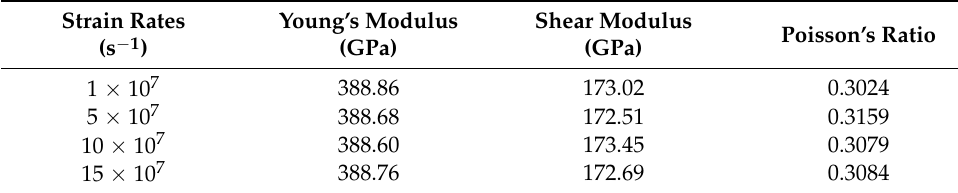
Table 2. Young’s modulus, shear modulus, and Poisson’s ratio of tungsten at different strain rates and pressure of 8